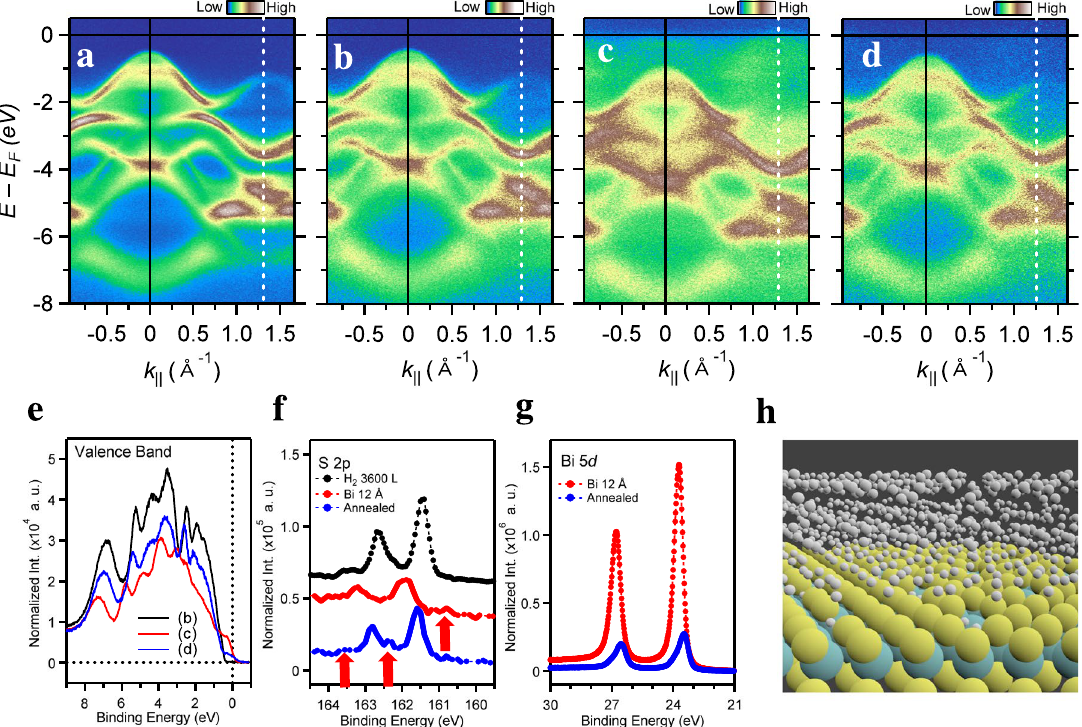
Figure 4. Estimation of the adsorbed hydrogen coverage on the MoS 2 surface. ( a )–( d ) ARPES intensity maps were measured along the Γ K high-symmetry lines before ( a ) and after ( b ) the 3600 L H 2 exposure on the cleaved MoS 2 surface, and subsequently Bi deposited on the surface of ( c ), and then annealed surface ( d ). ( e )–( g ) Valence band, S 2p and Bi 5d core-level spectra. ( h ) Schematic of the monolayer of physisorbed H 2 molecules based on chemisorbed H atoms on the monolayer MoS 2 with